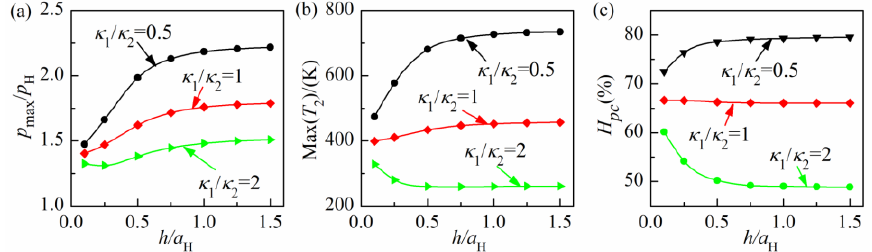
Figure 11. Effect of the coating thickness h on: ( a ) maximum contact pressure, ( b ) maximum surface temperature, ( c ) frictional heat partition coefficient.